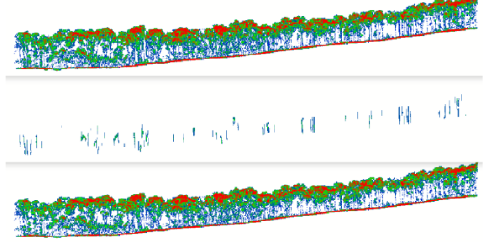
Figure 10: Voxelised point cloud